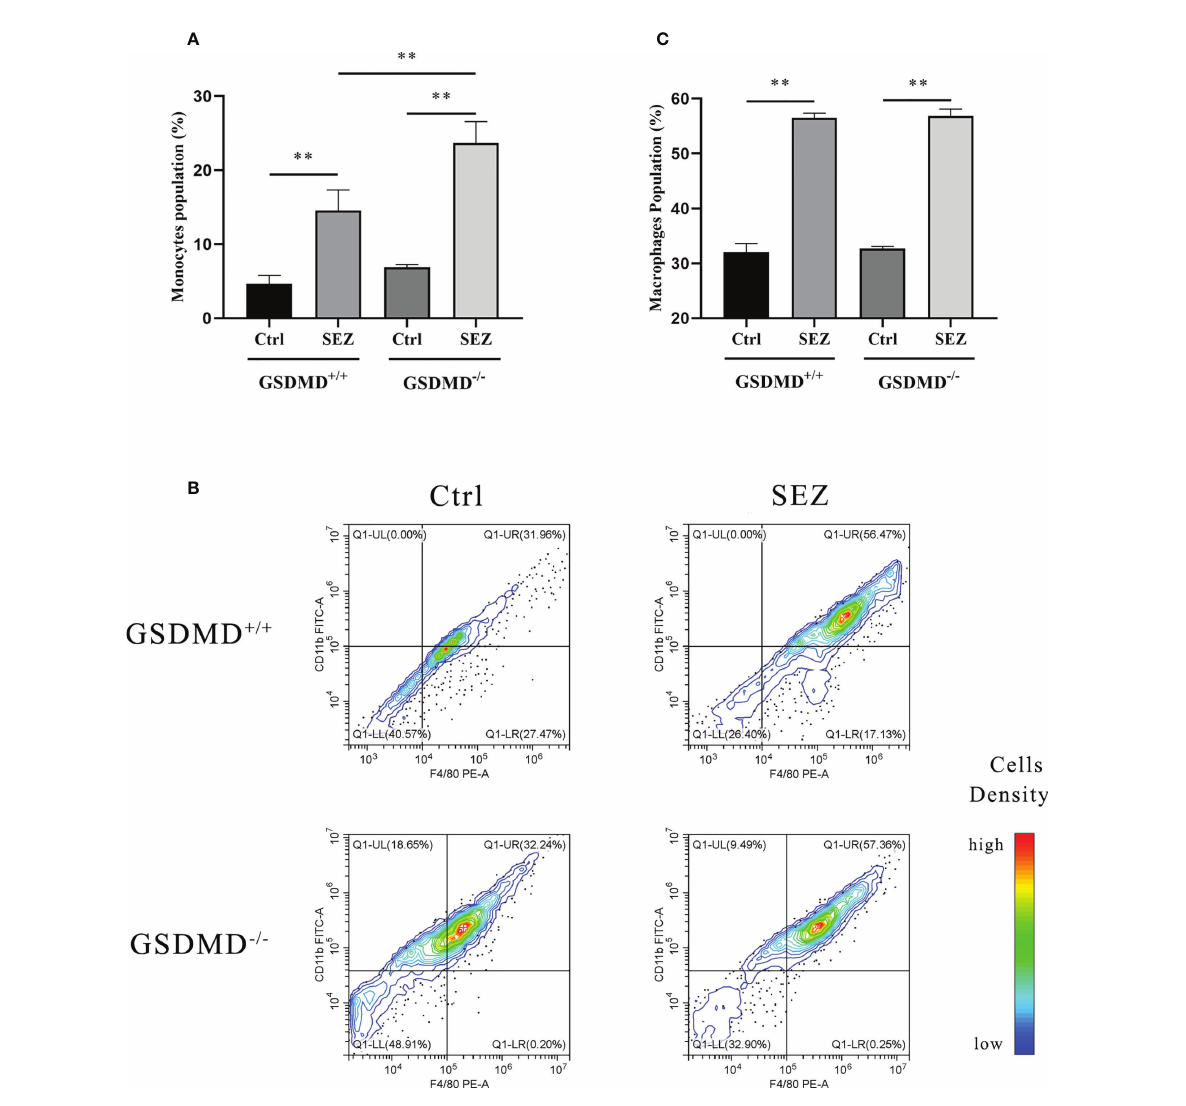
FIGURE 3 SEZ infection promotes the recruitment of macrophages in PLFv. (A) The number and proportion of monocytes collected from PLF of mice (n=5) were measured using Auto Hematology Analyzer, and (B) macrophages were assessed by F4/80/CD11b and analyzed by fl ow cytometry. A color scale bar was added to show the cells density (blue, green, and red represent low cell density, medium cell density, and high cell density, respectively). (C) The cell numbers in the upper right quadrant (F4/80-positive/CD11b-positive, macrophages) were counted and shown. All cells were isolated from mice infected or uninfected with SEZ (10 6 CFU) for 24 h. These experiments were conducted with 3 replicates. Data are expressed as mean ± SD. ** p <0.01, one-way